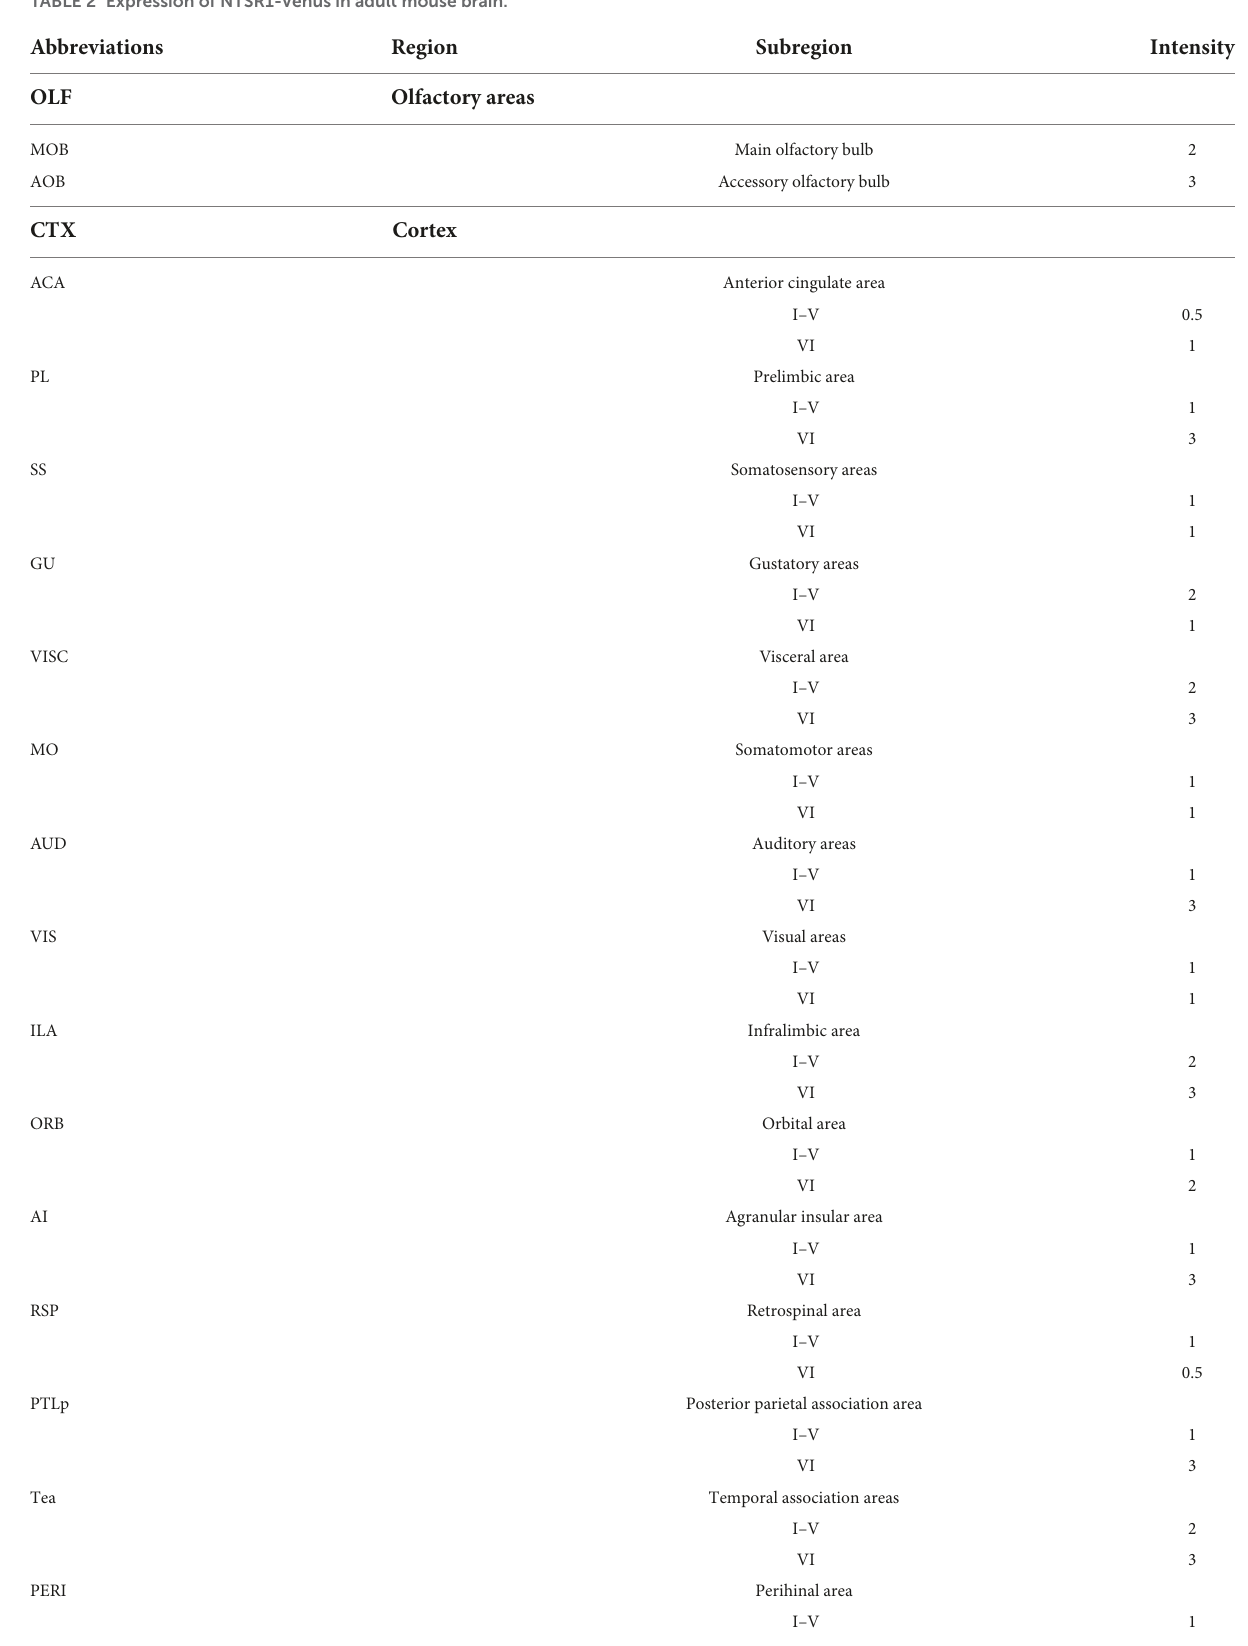
TABLE 2 Expression of NTSR1-Venus in adult mouse